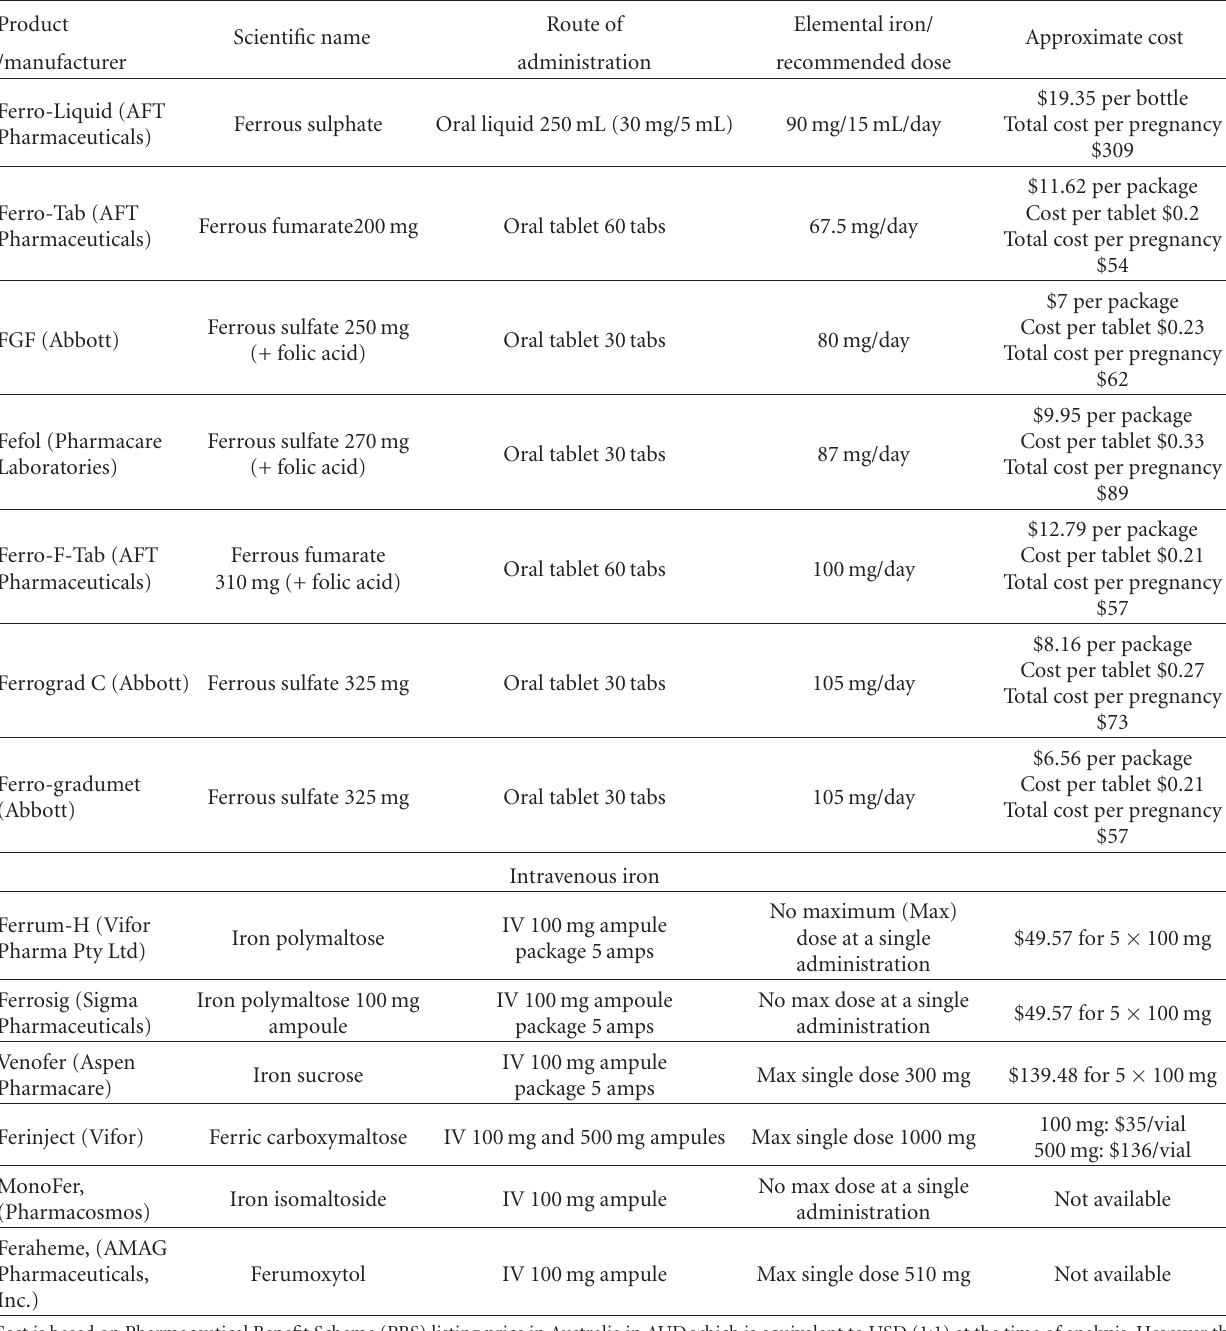
Table 2: Comparison of costs of di ff erent oral and IV iron